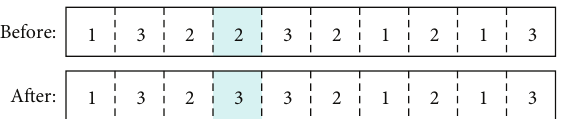
Figure 2: An individual with ten aircrafts before and after position updating.